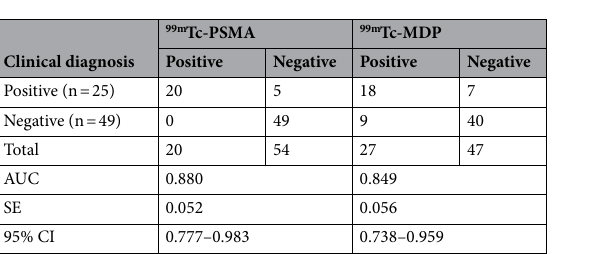
Figure 2. Flowchart of participant selection in the study.